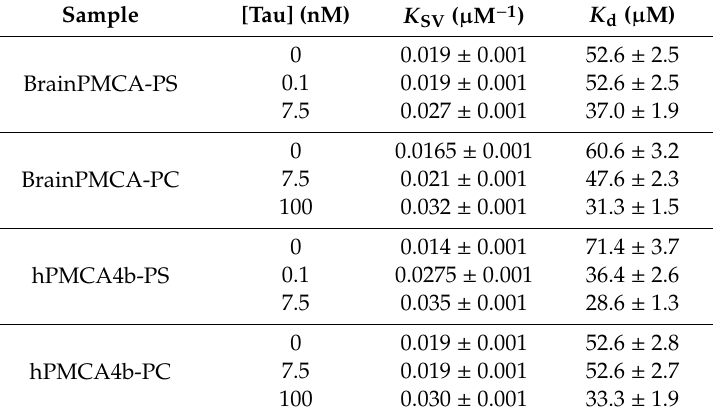
Table 1. Quenching by MB of the intrinsic fluorescence of purified pig brain PMCA (brainPMCA) and of purified yeast hPMCA4b, reconstituted in PS or PC. Fluorescence measurements were performed as indicated in the Materials and Methods and data were analyzed by linear regression fit to the Stern–Volmer equation ( R 2 > 0.93 in all